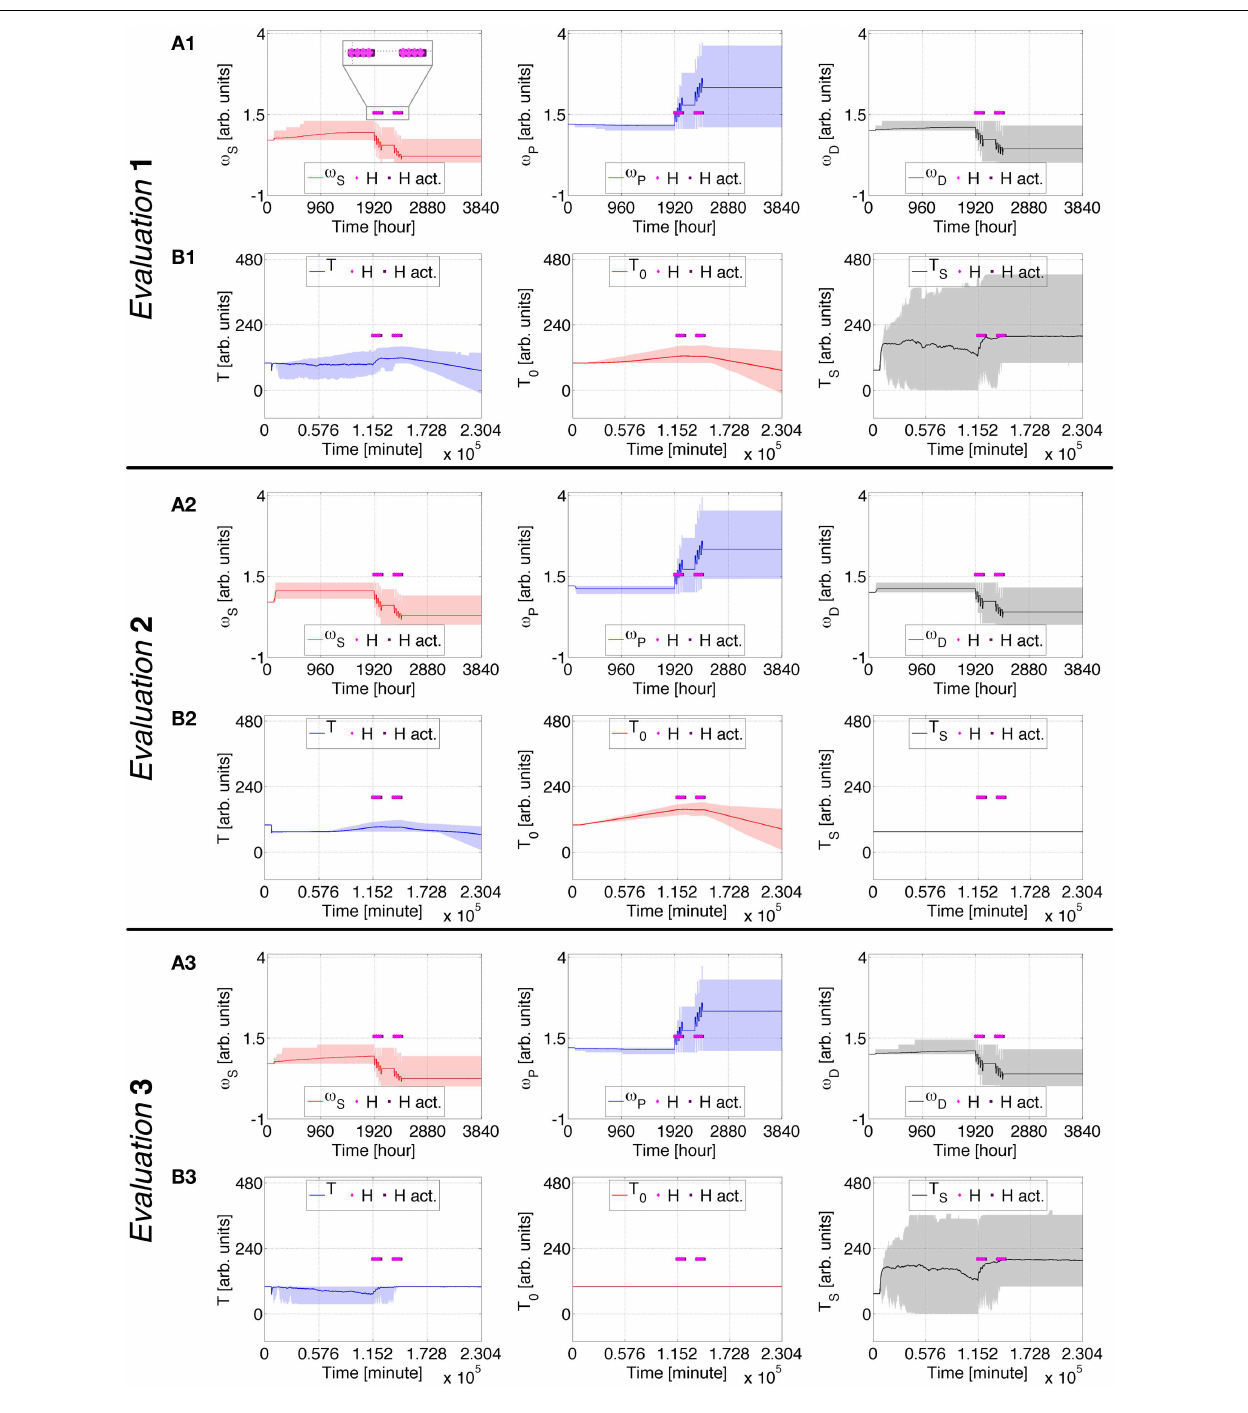
activated at t ∈ {1920, 1960, 2000, 2040, 2280, 2320, 2360, 2400} [hours] (in light pink) and stays active for 15h (dark pink). (A1–A3) show the evolution of cognitive weights ω S , ω P , and ω D ; and (B1–B3) the progression of T , T 0 , and T S .The shades correspond to 95% simulation envelopes.The time-scales are hours for (A1–A3 ), and minutes for (B1–B3) . Further details of these simulations are reported in FiguresS21 and S22 in Supplementary